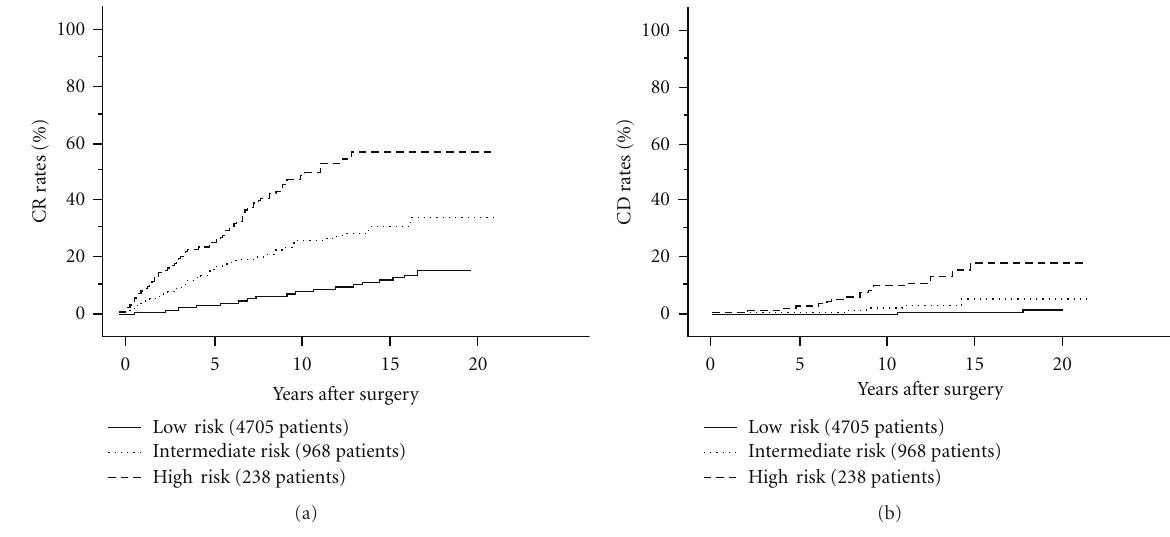
Figure 6: CR rates of PTC patients with low risk, intermediate risk, and high risk for lymph-node